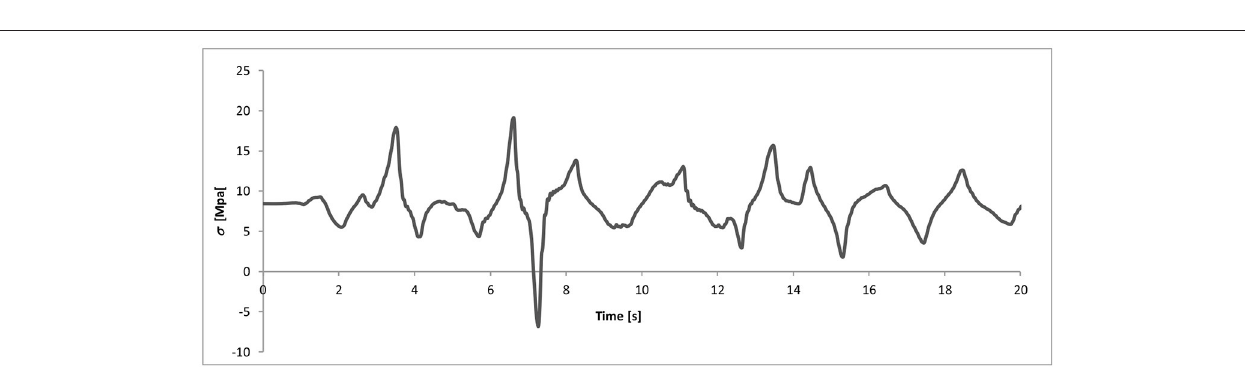
Frontiers in Built Environment |